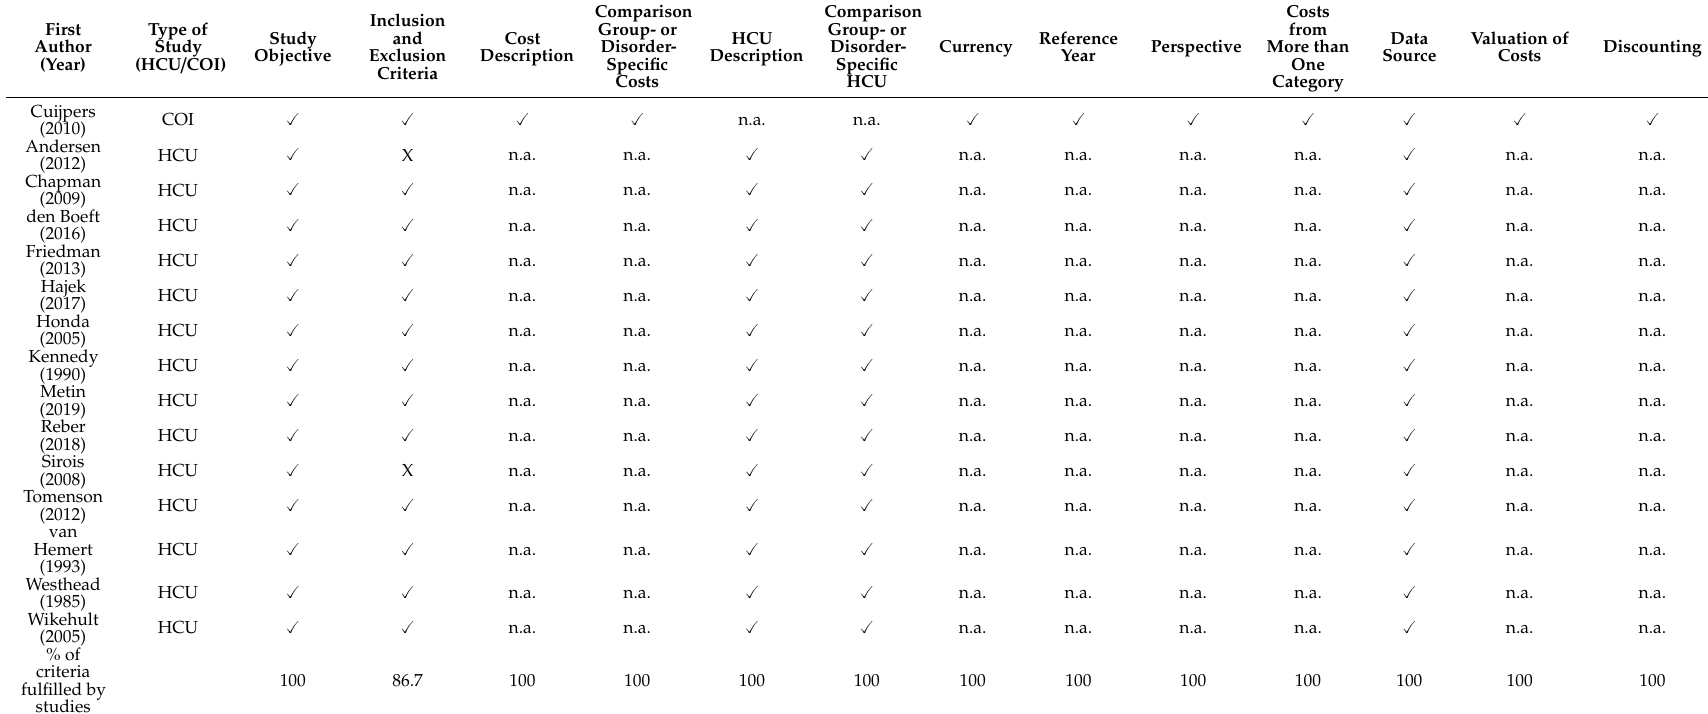
Table 3. Quality